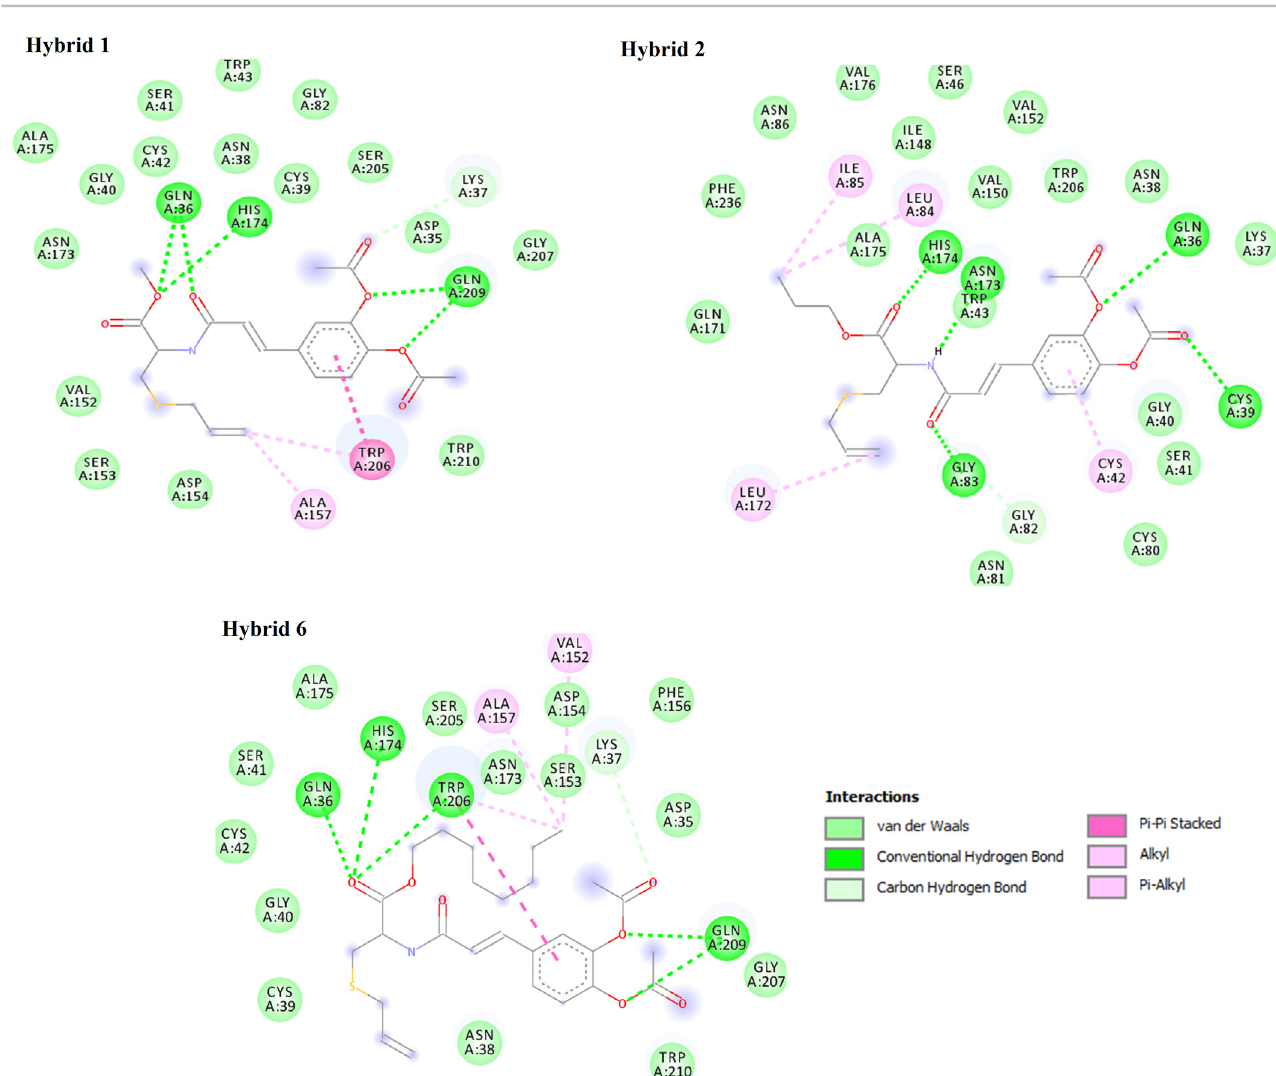
FIGURE 8 - 2D interaction modes plots for hybrids 1,2,6 inside hemoglobin cleavage site on FP-2. Interactions between each component and residues of FP-2 are indicated by the dashed